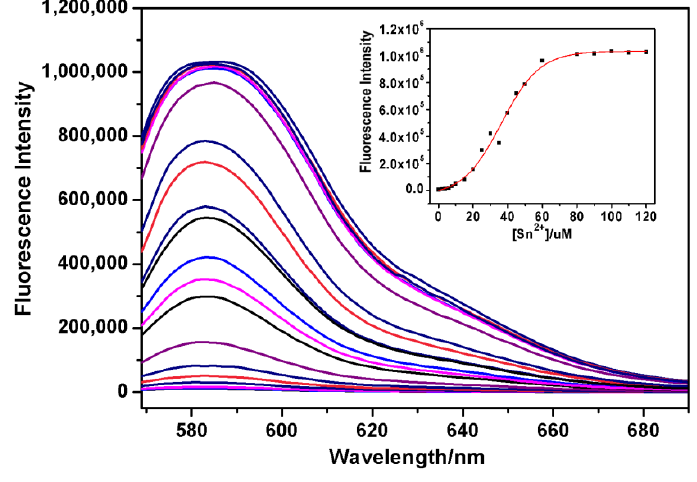
Figure 9. Changes in the fluorescence intensity of RBAP in MeOH/H pH 5.95) upon the addition of Sn 2+ . λ 583 nm upon the addition of Sn 2+